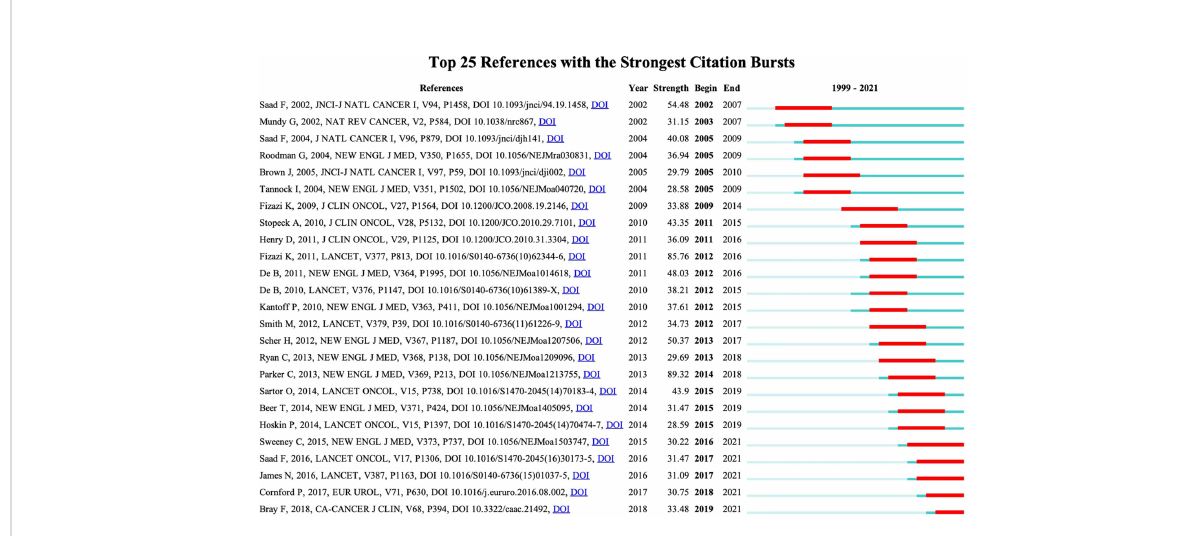
FIGURE 8 Visualization map of top 25 references with the strongest citation bursts from 1999 to 2021 generated by